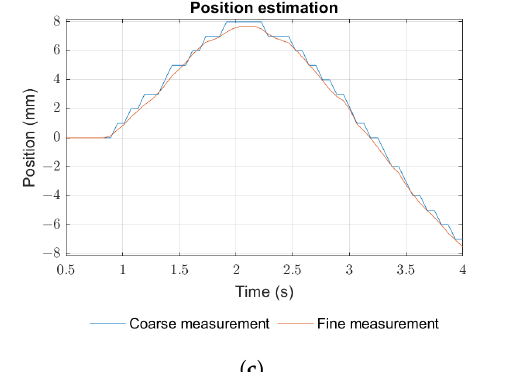
Figure 8. Encoder signals and reading: ( a ) raw channel signals, ( b ) normalized signals, ( c ) coarse and fine position readings from normalized signals.